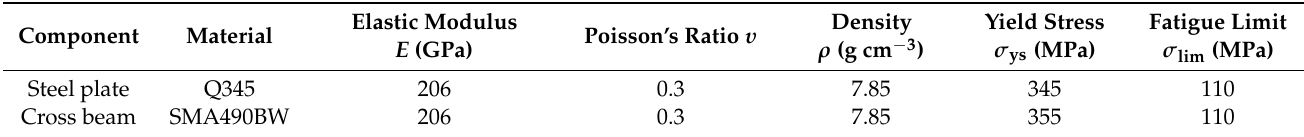
Table 1. Mechanical parameters of bogie frame